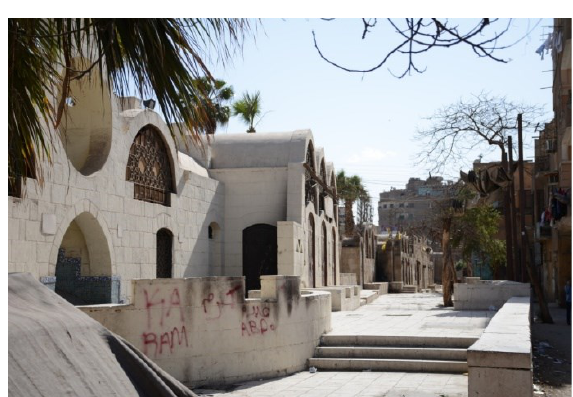
Figure 10 : View from Abu-ElDahab Street Entrance, Authors, 2018.